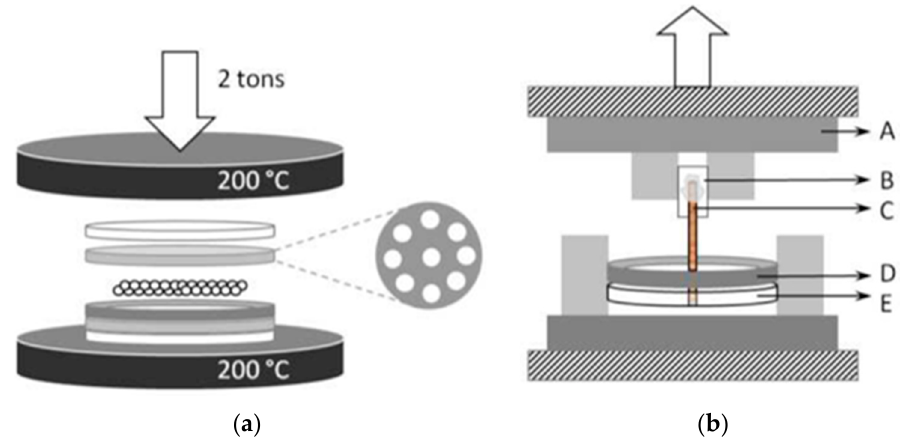
Figure 2. Procedure to obtain and test pull-out-samples. ( a ) creating poly(lactic acid) (PLA) thin disks. Between the hot plates of the hydraulic press (stacked from the bottom to the top ): a Teflon film, an aluminum foil, a washer filled with PLA pellets, a hole-punched aluminum foil and another Teflon film. ( b ) placing samples on the Bose device: (A) clamp, (B) cardboard, (C) free tip of the bamboo fiber, (D) washer, and (E) PLA thin disk.